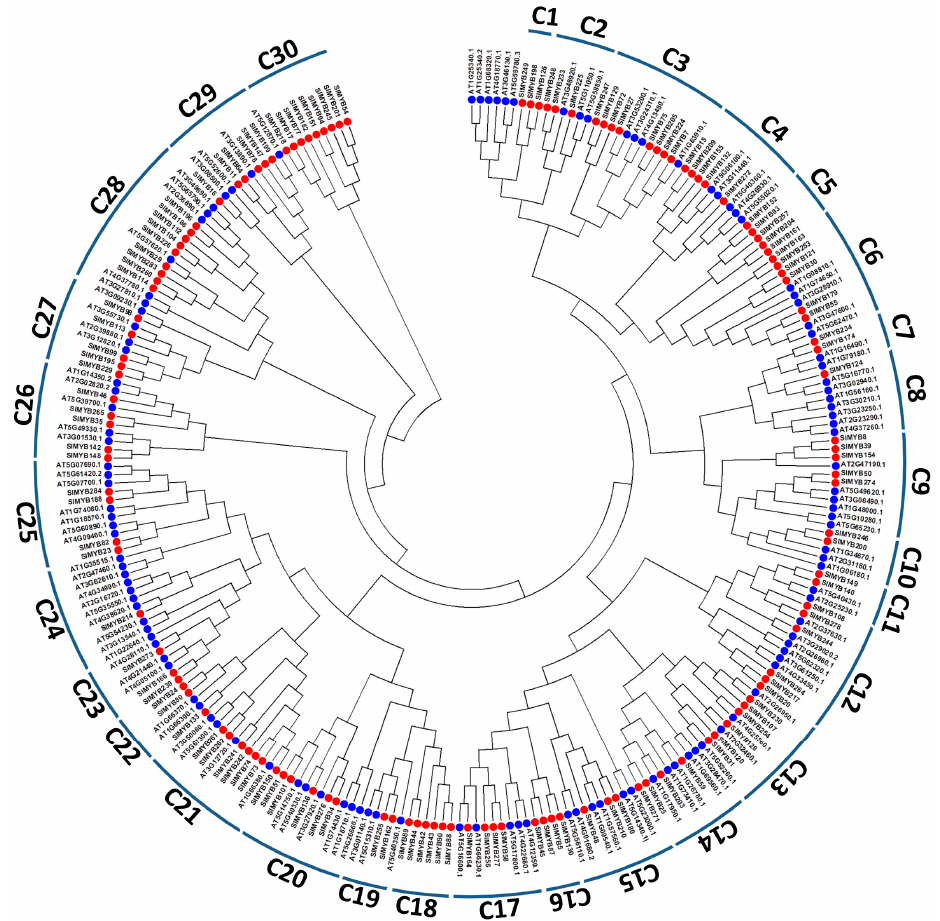
Figure 2. Phylogenetic relationships of the R2R3-MYB subfamily between sesame and Arabidopsis . The subgroups were designated as C1 to C30 following the classification in Arabidopsis [2]. Sesame SIMYBs are represented by the red dot whereas Arabidopsis MYB are labeled by a blue dot.